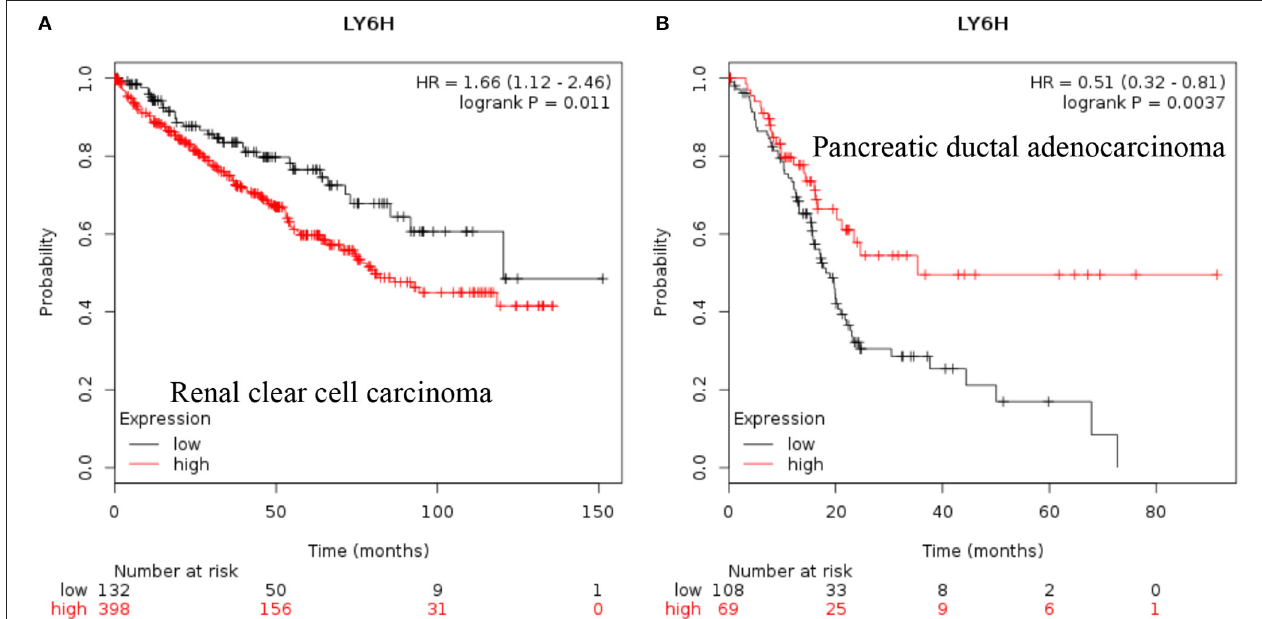
FIGURE 3 | Increased LY6H mRNA expression in cancer and patient survival. High LY6H RNA expression leads to poor survival in (A) renal clear cell carcinoma, (B) pancreatic ductal adenocarcinoma (38).